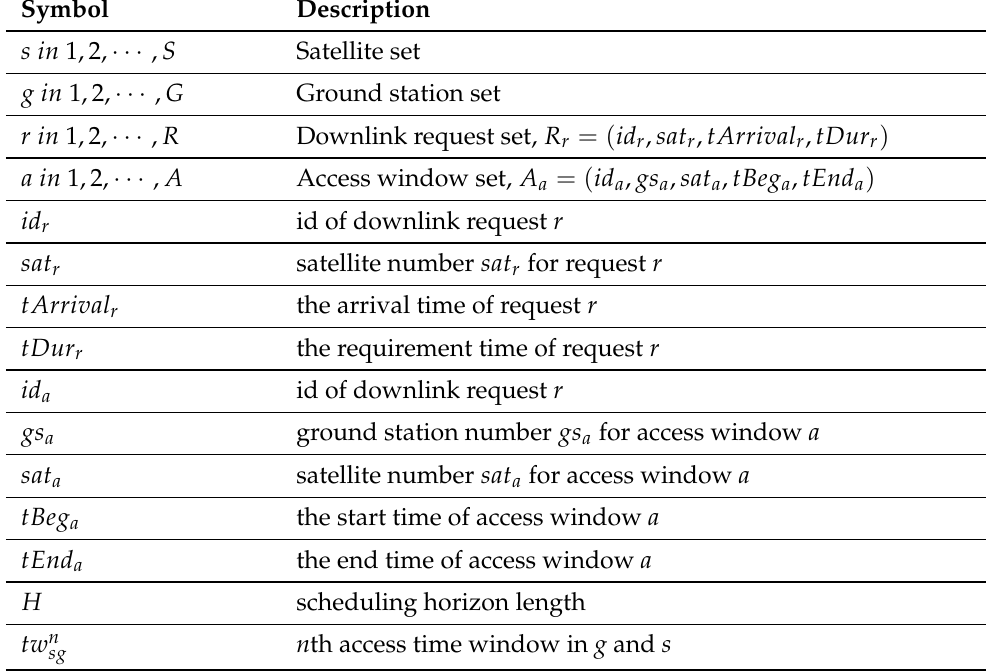
Table 1. Parameters.